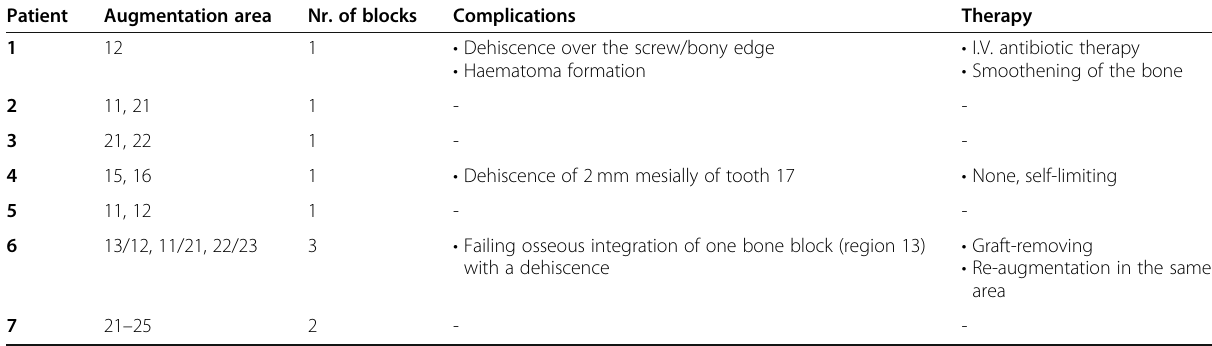
Table 2 Complications and treatment Patient Augmentation area Nr. of